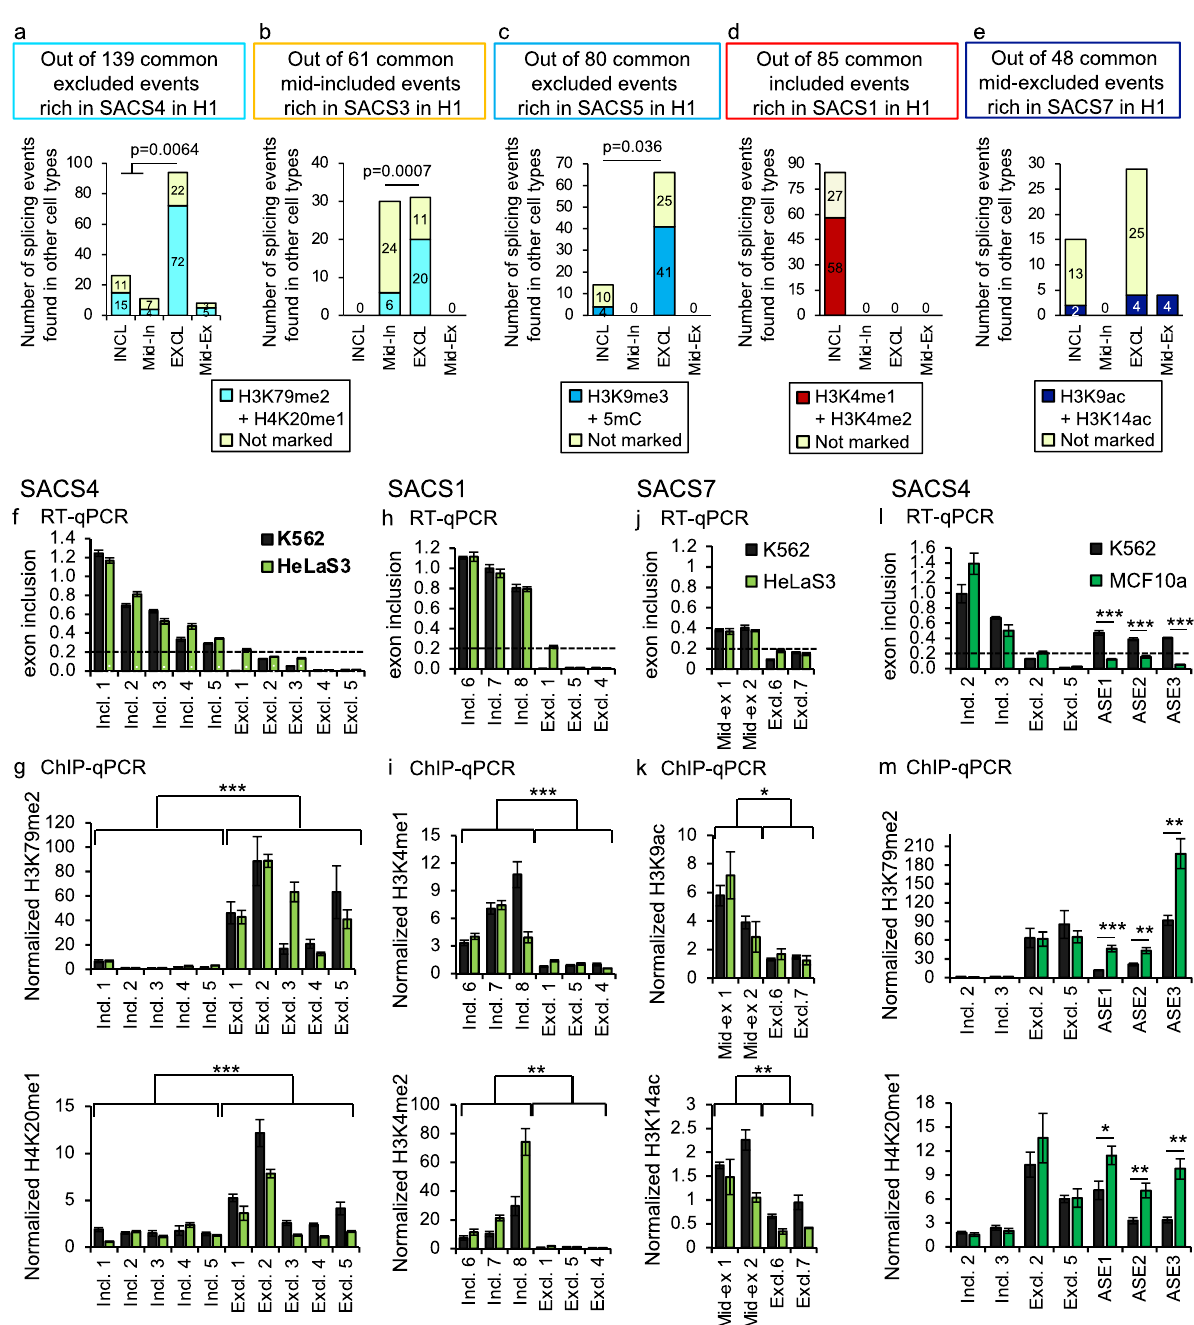
Fig. 4 Experimental validation of SACS exons in different cell lines. a – e Number of exons marked in SACS4 ( a ), SACS3 ( b ), SACS5 ( c ), SACS1 ( d ) or SACS7 ( e ) in H1 that maintain or not the SACS enrichment when spliced in other cell lines in which the appropriate epigenomics data is available (details about the cell lines in Supplementary Data 1). Exons were grouped into included (Incl.), excluded (Excl.), mid-included (Mid-in.) or mid-excluded (Mid-ex.) depending on the pattern of splicing in the other cell lines analysed. Only alternatively spliced events co-expressed in H1 and any of the other cell lines are studied. p -value < 0.05 in Fisher ’ s exact test, two-sided. f – k Experimental validation of the results obtained in silico. H3K79me2, H4K20me1, H3K4me1, H3K4me2, H3K9ac and H3K14ac enrichment levels at alternatively spliced exons that are included (Incl.), excluded (Excl.) or mid-excluded (Mid-ex) in K562 (black) and HeLa S3 (light green) cells. In f , h , j , exon inclusion levels are normalised by total expression levels of the corresponding gene. Below 0.2 (highlighted with a dotted line) the exon is considered excluded. Data is depicted as the Mean ± SEM of n = 4 independent experiments by quantitative RT- qPCR. In g , i , k the enrichment levels (% input) of the studied histone marks at the alternatively spliced exon are normalised to two control regions that remain unchanged between cell types. Data is depicted as the Mean± SEM of at least n = 4 independent experiments by quantitative ChIP-qPCR. ** p -value < 0.01, *** p -value < 10 − 5 ( T -Test, two-sided). l , m Same as f , g , but this time three alternatively spliced events (AS) that switch exon inclusion levels between K562 (black) and MCF10a (green) are shown. Two included and two excluded events that do not change between cell types are shown as controls. * p -value < 0.05, ** p -value < 0.01 and *** p -value < 0.001 ( T -Test, two-sided).